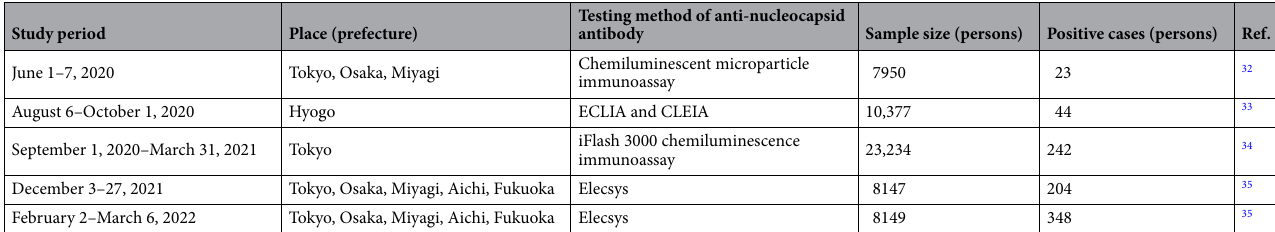
Table 4. Five seroepidemiological surveys of COVID-19 conducted in Japan, 2020–2022.